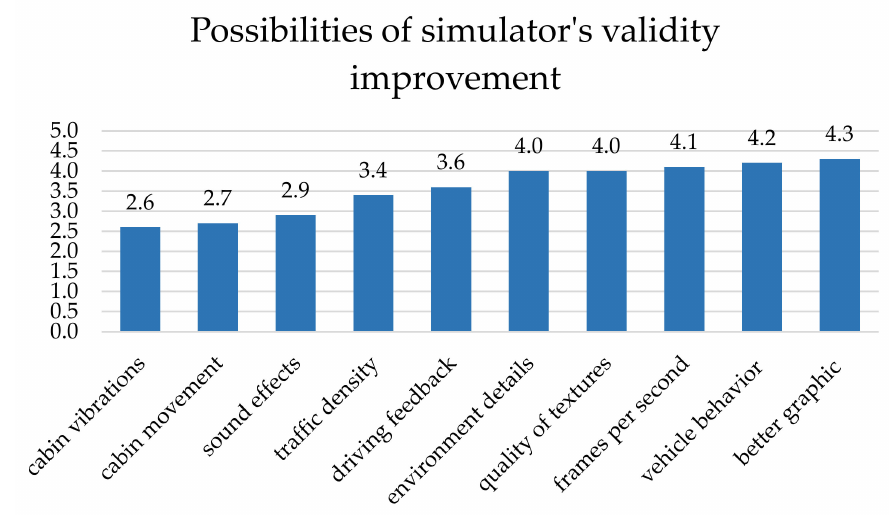
Figure 8. Possibilities of improving driving simulator validity. Source: Processed by